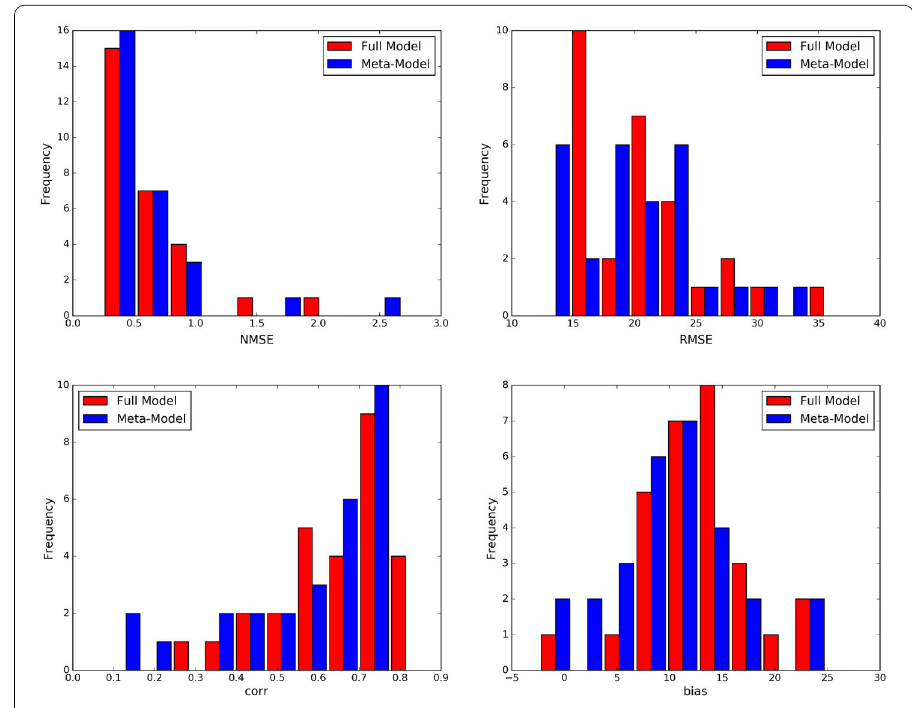
Fig. 12 Scores of the Sirane NO 2 concentration field compared to the observation data over the month of November 2014. Top left: NMSE (11). Top right: RMSE (10). Bottom left: correlation (12). Bottom right: bias (13)